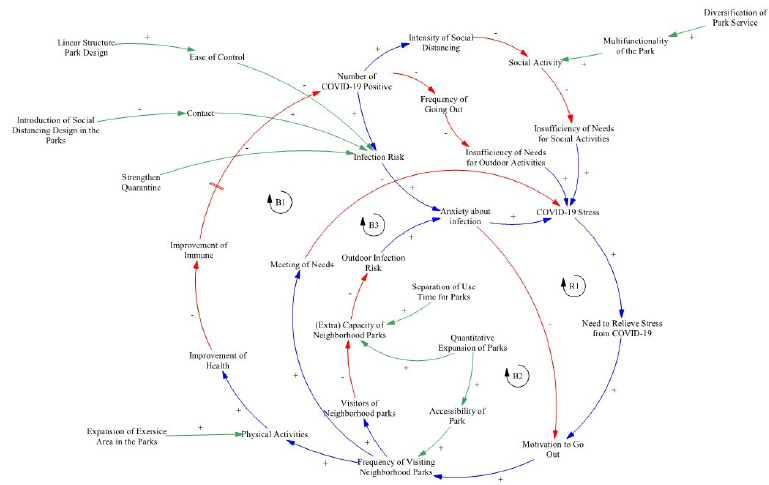
Figure 2. A causal loop diagram for COVID-19 around neighborhood parks . Table 2. Neighborhood park COVID-19 response feedback structure .